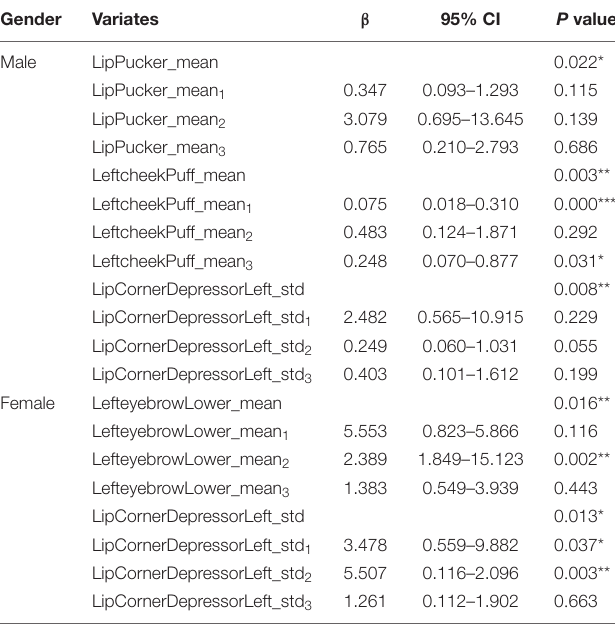
TABLE 4 | The relationship between AUs’ movement and self-esteem.